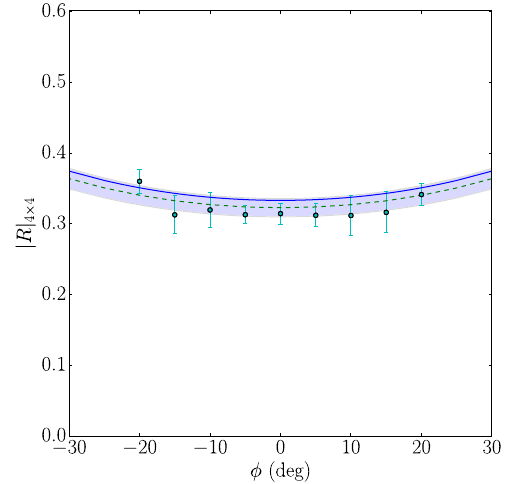
FIG. 7. Measured scaling for the 4 × 4 transfer matrix deter- minant as a function of injected-beam energy (symbols) com- pared with the Chambers ’ approximation solid line) and numerical simulations using the 3D field map (dashed line). The shaded area represents the uncertainty on the simulations due to rf calibration